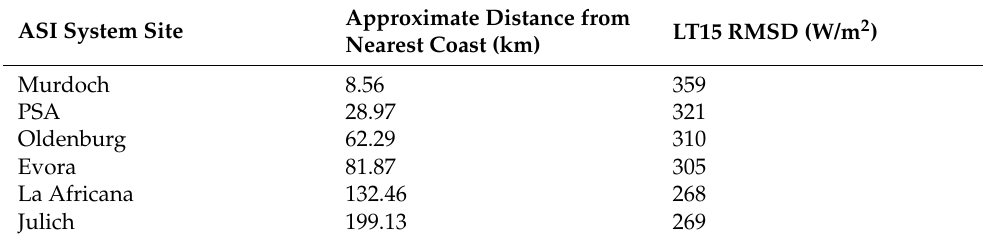
Table 10. ASI system’s distance from the nearest coast and LT15